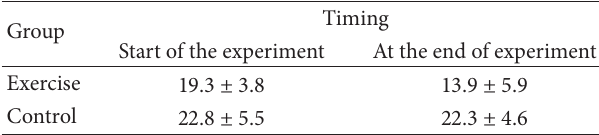
Table 1: Mean of restless leg syndrome scoring in both